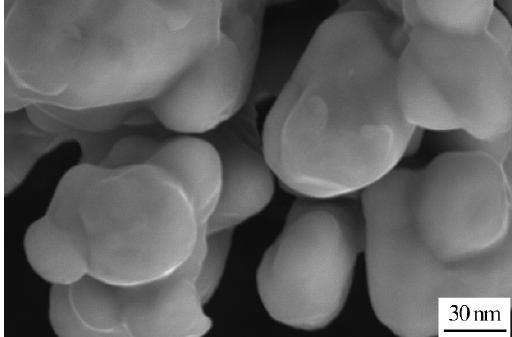
Figure 4. SEM image of Cu nanoparticles.